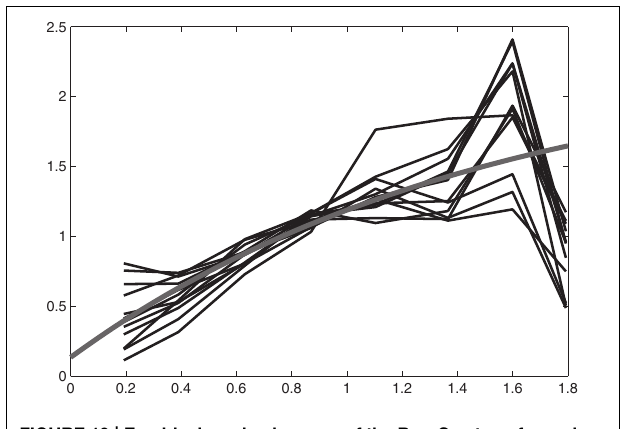
FIGURE 10 | Empirical semivariograms of the Box-Cox transformed standardized rain residuals for all of the 12 months and a fitted exponential semivariogram (gray). The same Box-Cox parameter λ 0 . 25 is used for the calculation of all variograms. = −